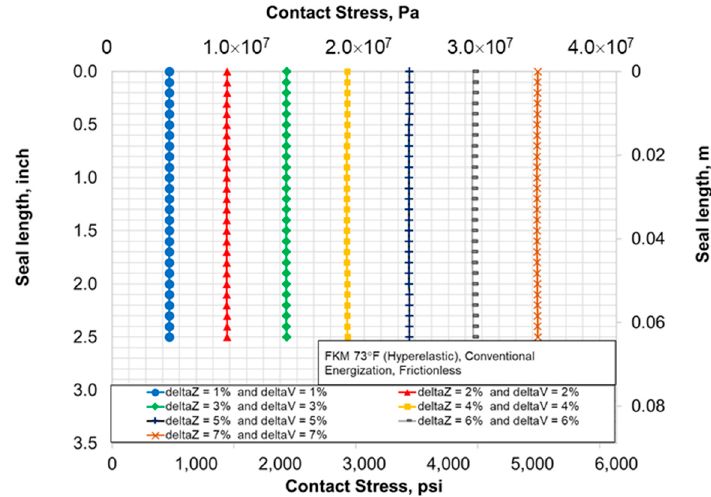
Figure 13. Contact stress profiles in conventional seal assembly for hyper-elastic FKM.